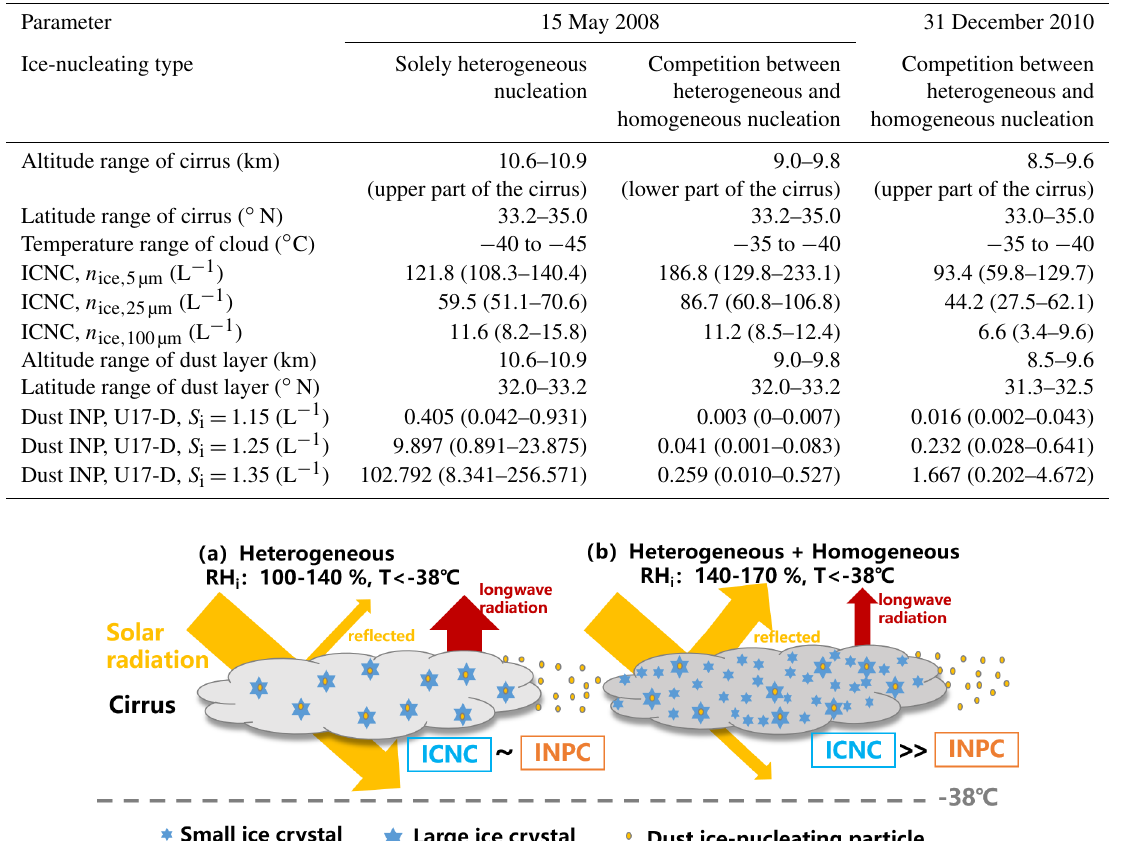
Table 2. Overview of in-cloud ICNC and dust INPC for the two cases on 15 May 2008 and 31 December 2010 in central Chinese regions. The ICNC values are provided by the DARDAR Nice data product. The INPC values are retrieved from CALIOP dust extinction coefficient based on the POLIPHON method. The layer-average values for ICNC and INPC are given together with the minimum and maximum values in parentheses. S i denotes the ice saturation ratio.